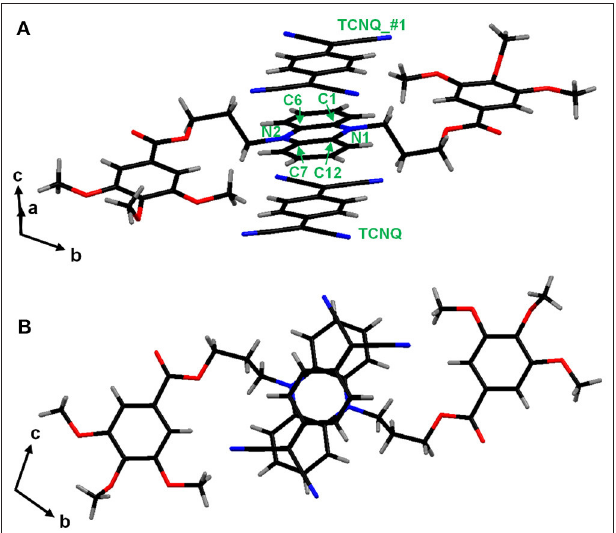
TABLE 1 | XRD data for cast films of DHP(8-12)-TCNQ and DHP(2-6)-TCNQ .